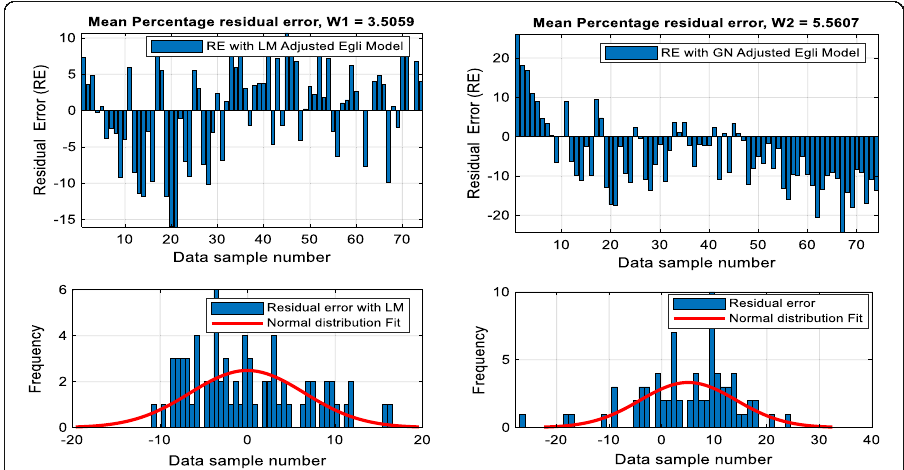
Fig. 9 Measured propagation loss estimation and their error distribution statistics using classical Egli model and adapted Egli model for